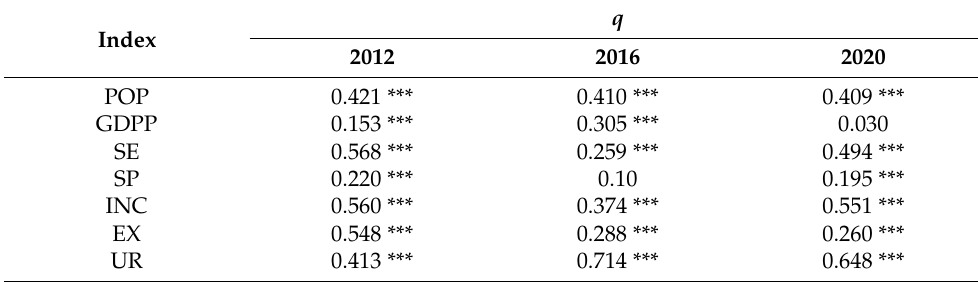
Table 5. Detection results for influencing